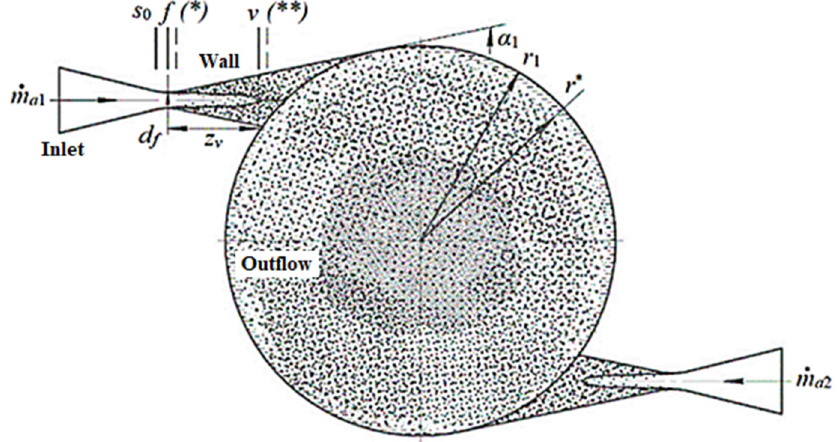
Figure 2. The design scheme of structural transformations of boiling liquid in the initial cross-section I-I of the vortex camera: s 0 —cross-section, in which the saturation parameters for the active flow are set; f —fluid flow cross-section; v —a cross-section of structural transformations of the flow; (*)—the first critical section; (**)—the second critical section; . . m a 1 , m a 2 —mass flow rate of the active flow; d f —the diameter of the fluid flow section; z v —longitudinal coordinate; α 1 —the oblique-cut angle of the nozzle; r 1 —the radius of the vortex chamber; r *—the radius of the initial bubble boiling point.